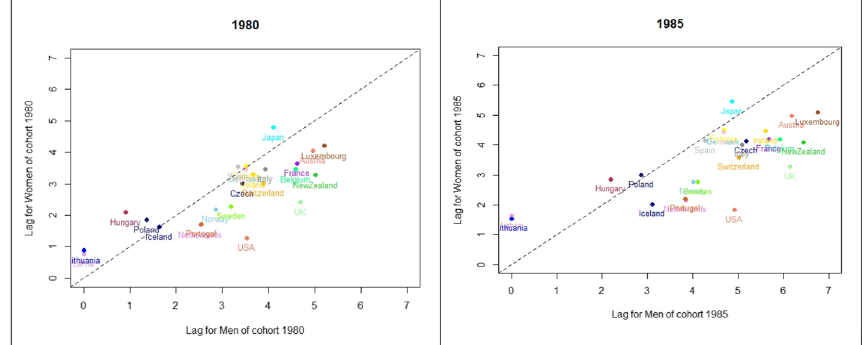
Fig. 3 Scatter-plot of gender-specific lags to be applied to NRA for selected countries